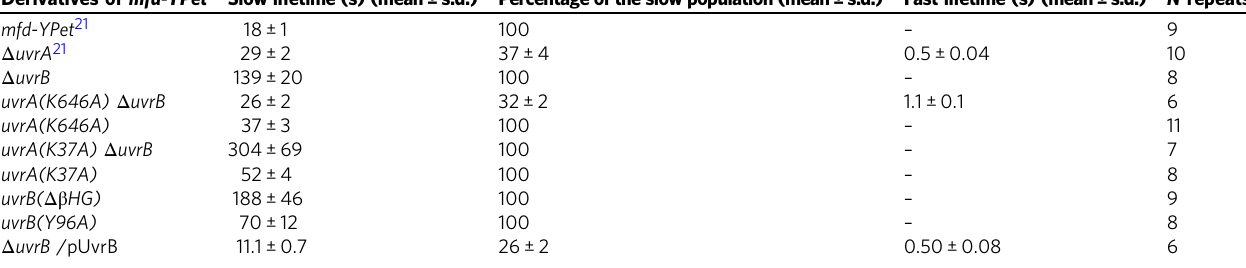
Table 1 Lifetimes of Mfd-YPet in various genetic backgrounds. Derivatives of mfd-YPet Slow lifetime (s) (mean±s.d.) Percentage of the slow population (mean±s.d.) Fast lifetime (s) (mean±s.d.) N repeats mfd-YPet